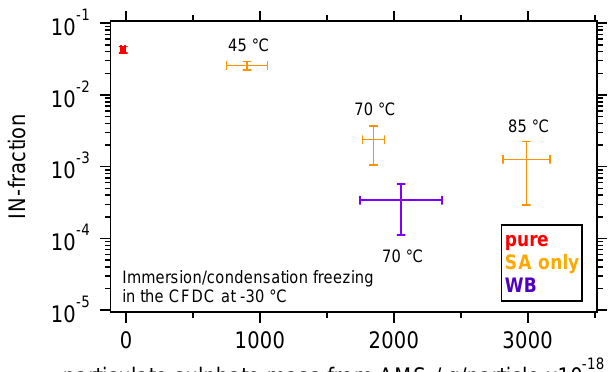
Fig. 10. Comparison of AMS sulphate per particle masses to CFDC ice nucleus counter at − 30 ◦ C in the immersion-freezing regime (adapted from Sullivan et al., 2010b). Different coating tempera- tures are shown for the different particle classes. The particle class pure includes those experiments with no treatment and no sulphuric acid condensation. The particles class “SA only” includes particles which passed the sulphuric acid bath but no further processing was performed and WB indicates the use of the water bath. The IN- activity of the ATD is reduced if more sulphuric acid is condensed on the particle surface and the use of the water bath decreases the number of IN even further.